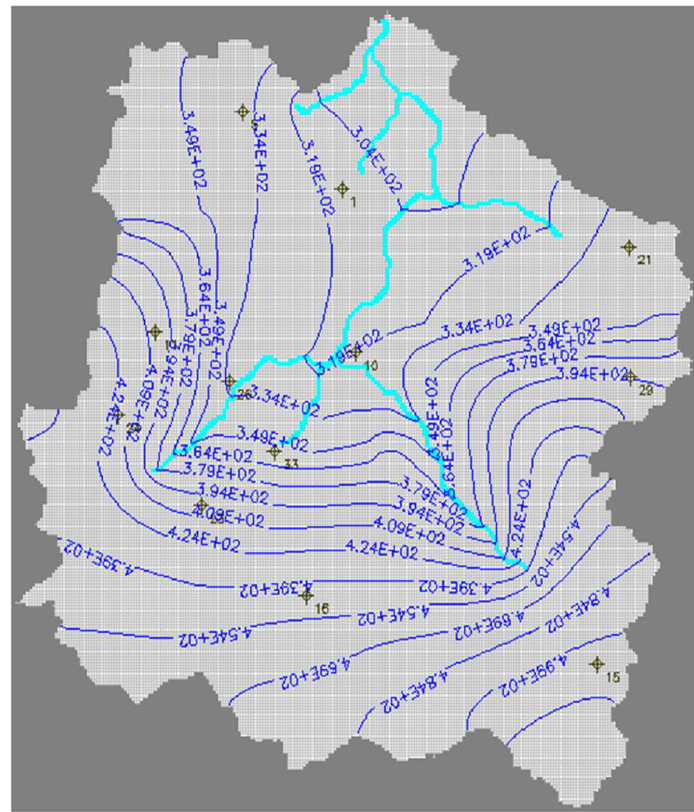
Figure 9. Calculated hydraulic heads (mamsl) in the steady-state simulation, with borehole locations used to calibrate the model. Table 3. Summary of calibration errors in the transient simulation (MAE: Mean Absolute Error;